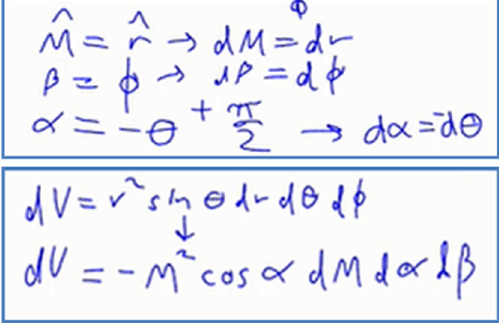
FIG. 5. Rachel and Silas directly compare coordinate systems and account for changes in variable placement as they construct a volume element.